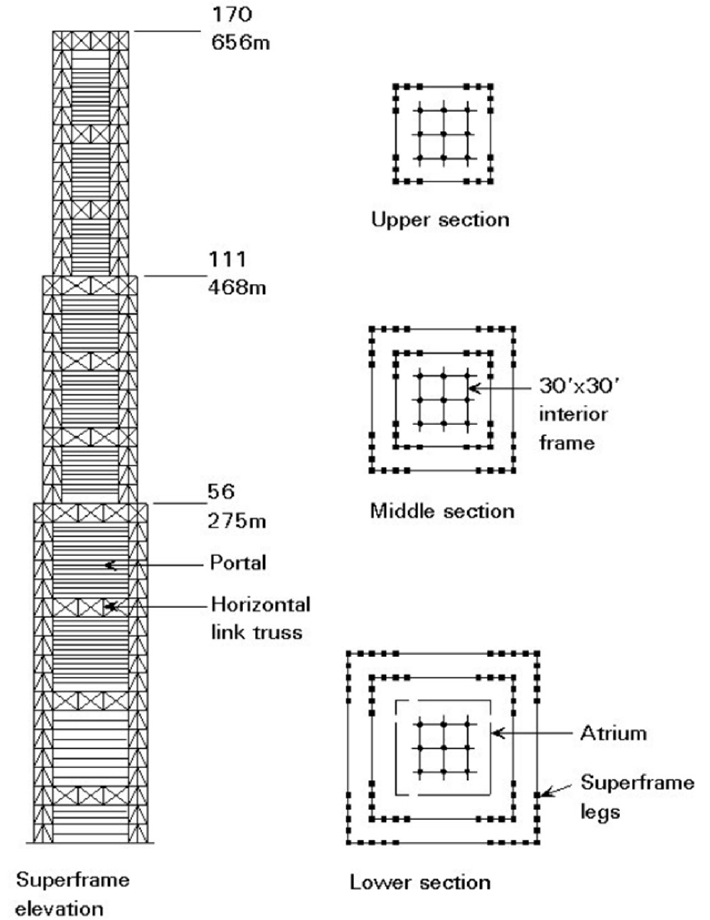
Figure 10. Vertically Stacked Superframes (unbuilt 168-story Chicago World Trade Center). (Source: Wikipedia).